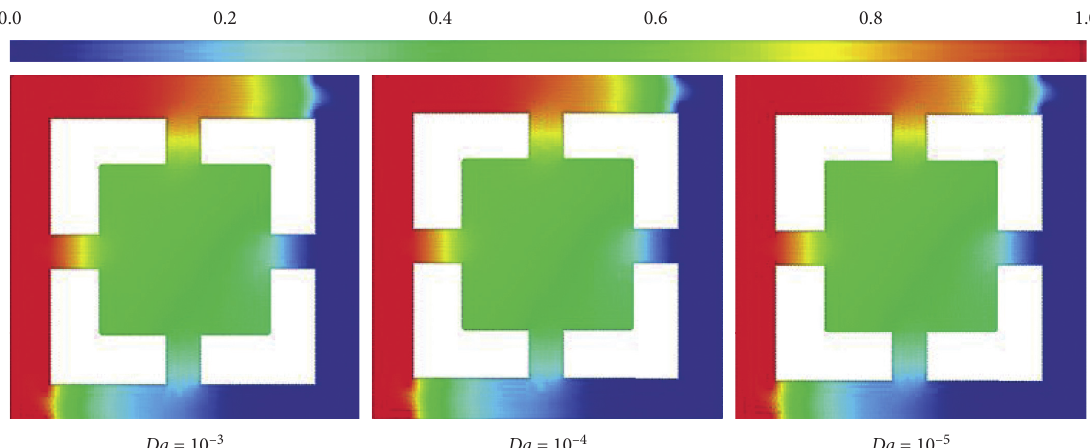
Figure 6: Features of temperature below the variations of a Darcy parameter at N � 1 , Ra � 10 4 , ϕ � 0 . 01, η and τ �